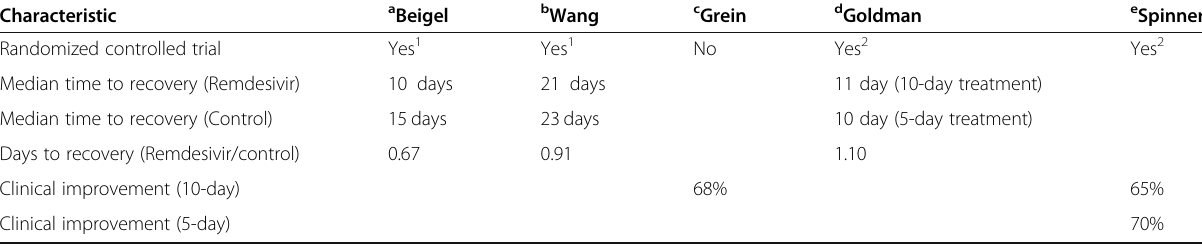
Table 2 Efficacy of remdesivir in human clinical trials